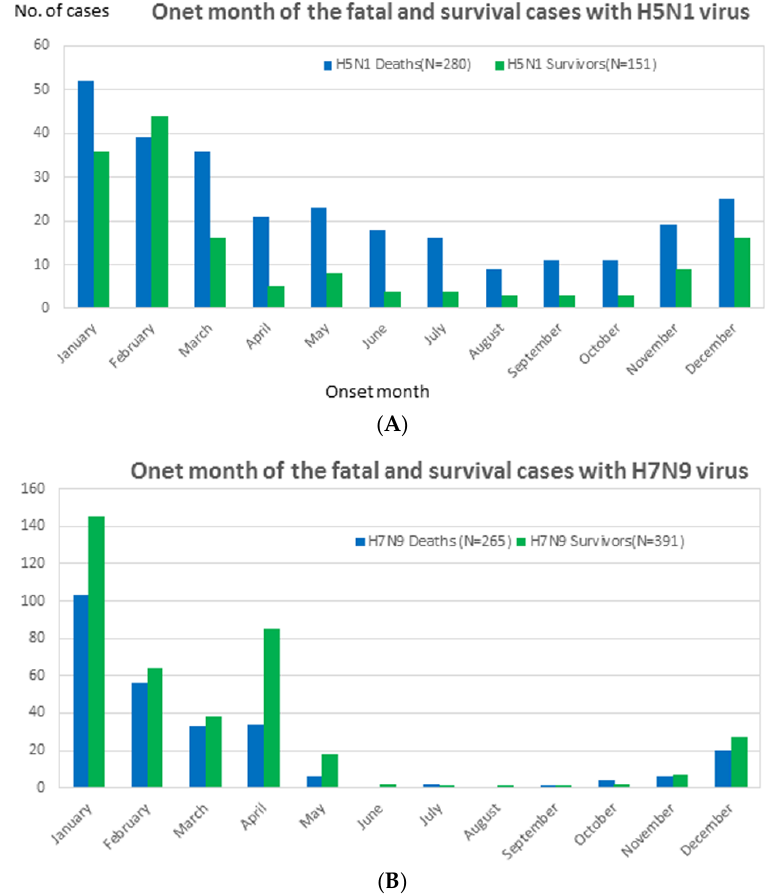
Figure 2. The onset month distribution of highly pathogenic avian influenza A (H5N1) and low pathogenic A (H7N9) virus fatalities and survivors until November 2016. ( A ) The onset month distribution of highly pathogenic avian influenza A (H5N1): survivors (N = 280) and deaths (N = 151). ( B ) The onset month distribution of low pathogenic A (H7N9) viruses: survivors (N = 265) and deaths (N = 391).